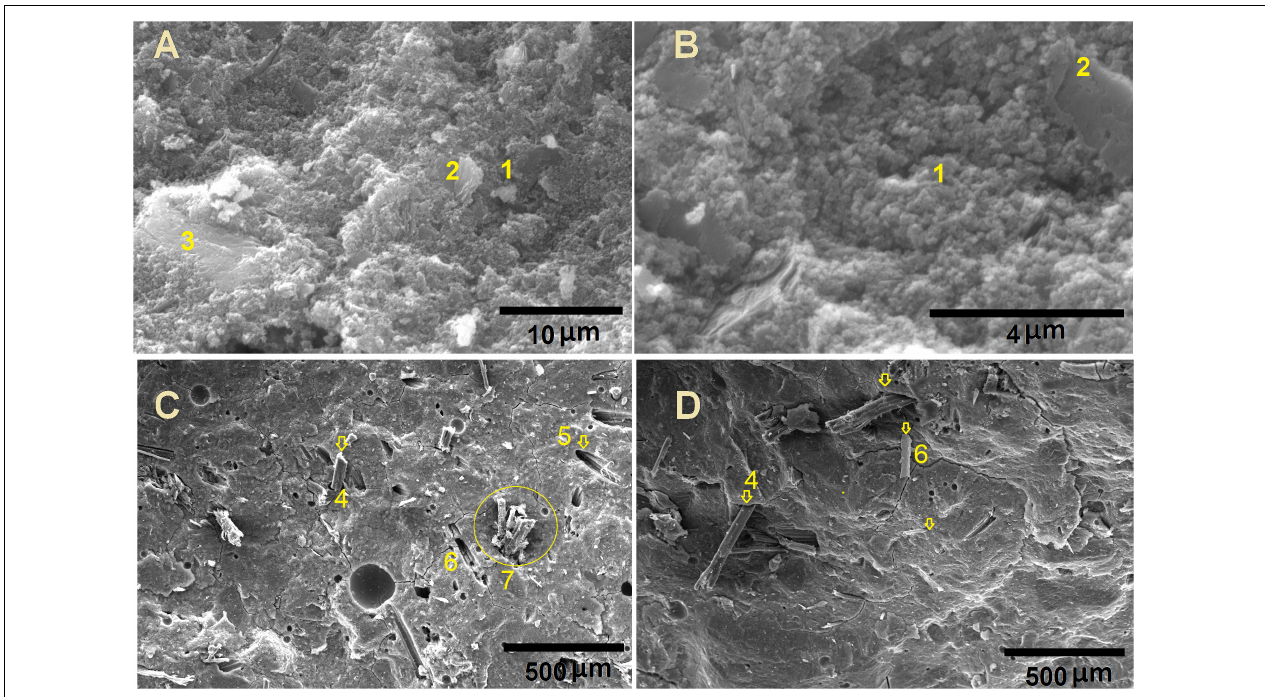
FIGURE 12 | SEM images of RJG3 (A) , RJG3 (B) , and fracture morphology of RJG3 (C) and of RJG2 (D)